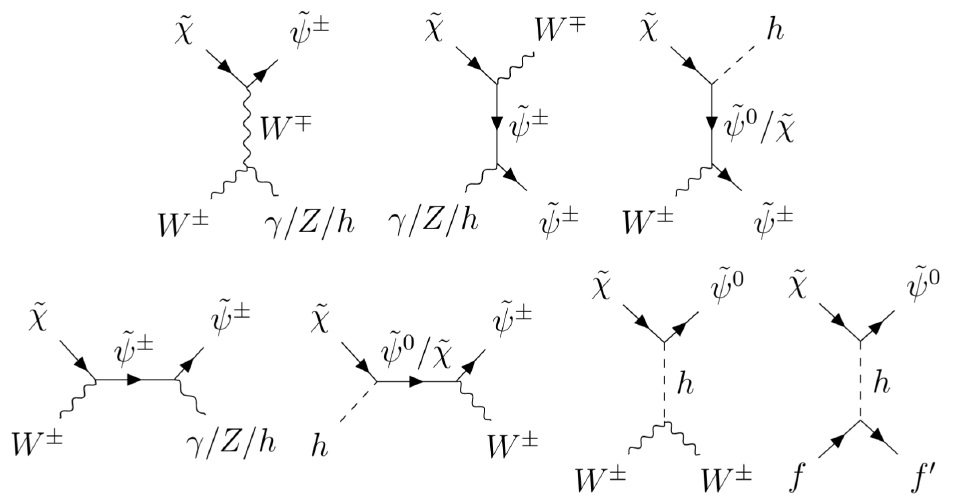
Figure 2: Subdominant co-scattering processes in the